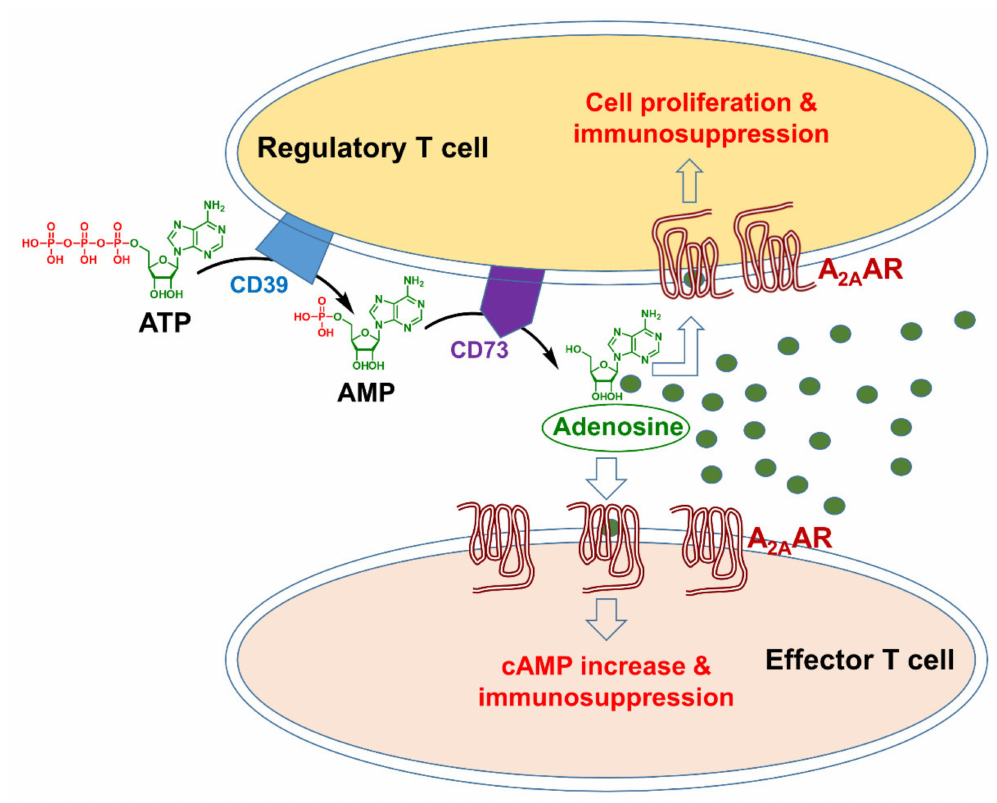
Figure 1. Adenosine-A 2A AR signaling in the tumor microenvironment (the green circles represent adenosine molecules). ATP = adenosine triphosphate; AMP = adenosine